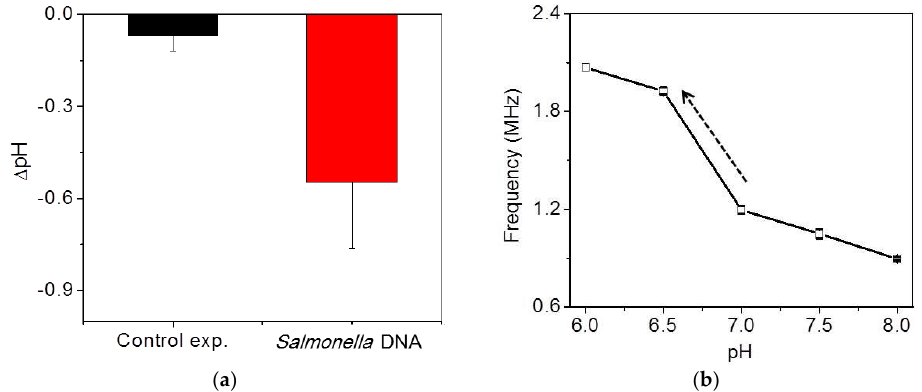
Figure 6. ( a ) Ex-situ pH variations of DNA and control samples using a commercial pH detector after isothermal amplification; ( b ) frequency variations with respect to standard pH.